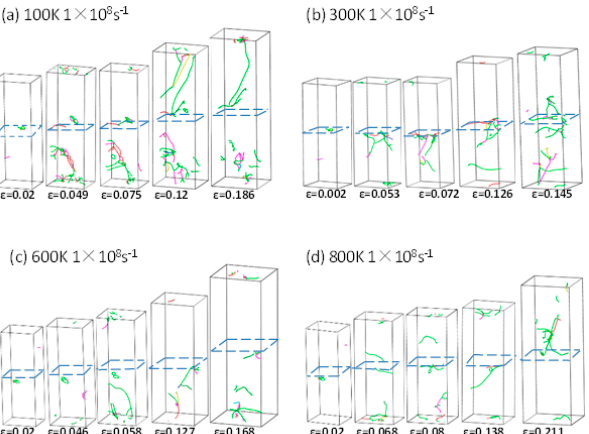
Figure 13. The DXA diagram of GBs HEAs under tensile. ( a ) 100 K, 1 × 10 8 s − 1 ; ( b ) 300 K, 1 × 10 8 s − 1 ;